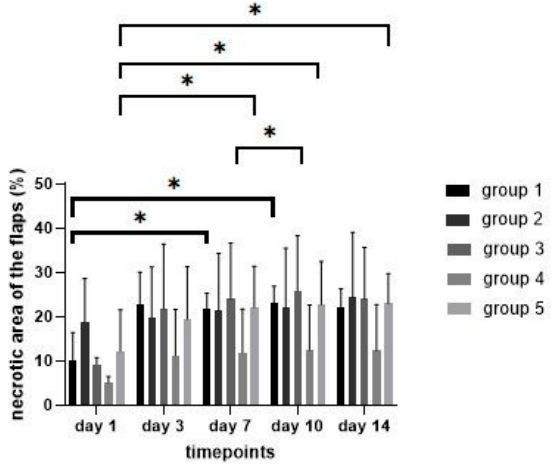
Figure 5. Flap size over time in the different treatment groups.